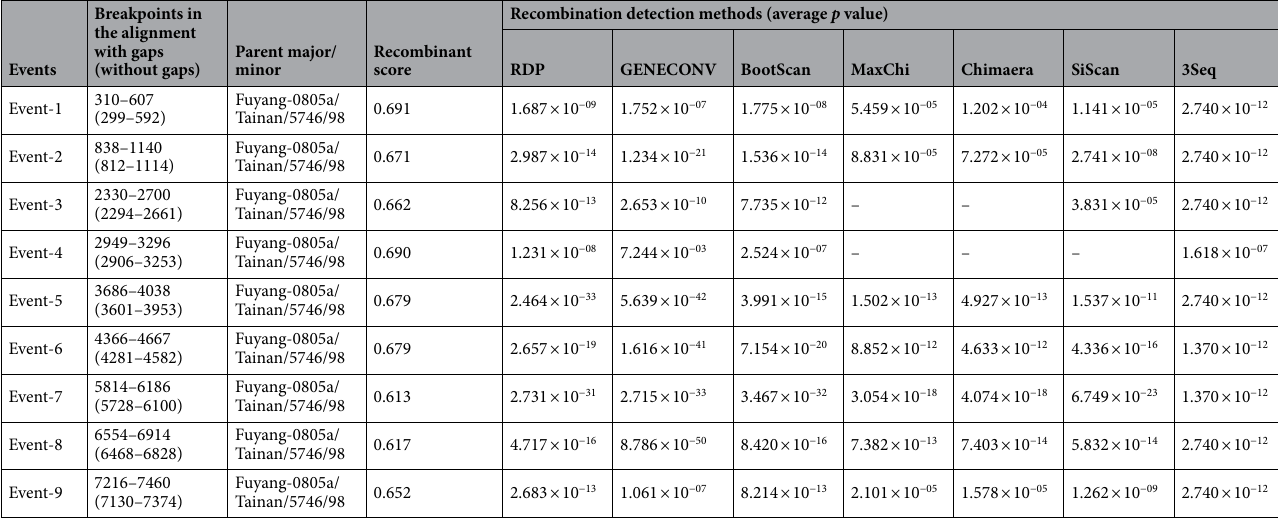
Table 2. Recombination events detected with RDP4 from the alignment of the complete genome of DL71.